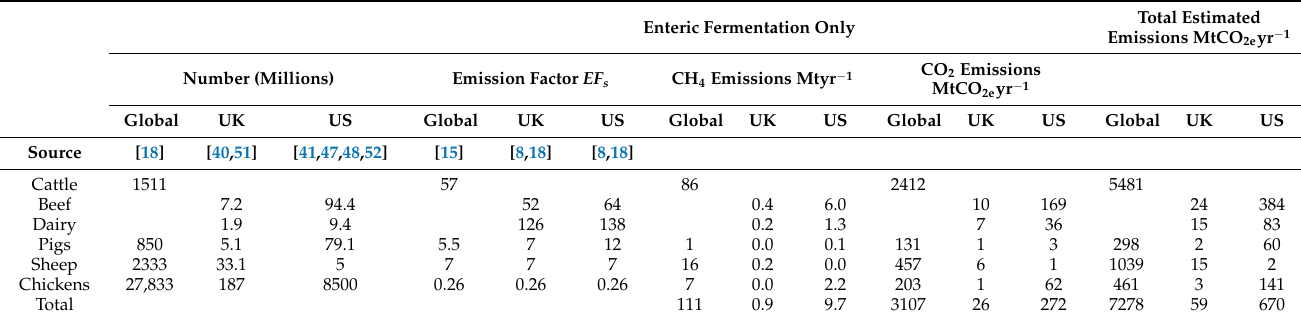
Table 5. GHG emissions from enteric fermentation and estimated total GHG emissions (including all sources as described in Section 2.1) from selected livestock species. Note that species like buffalo are not included. Calculations are made using Equation (5) and the methodology outlined in Section 2.1.